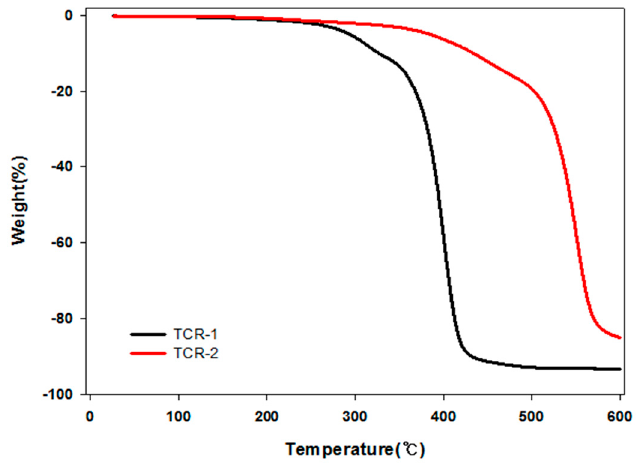
Figure 8. Thermal stability of the PMBA/PFSM core-shell nanoparticles to the order of